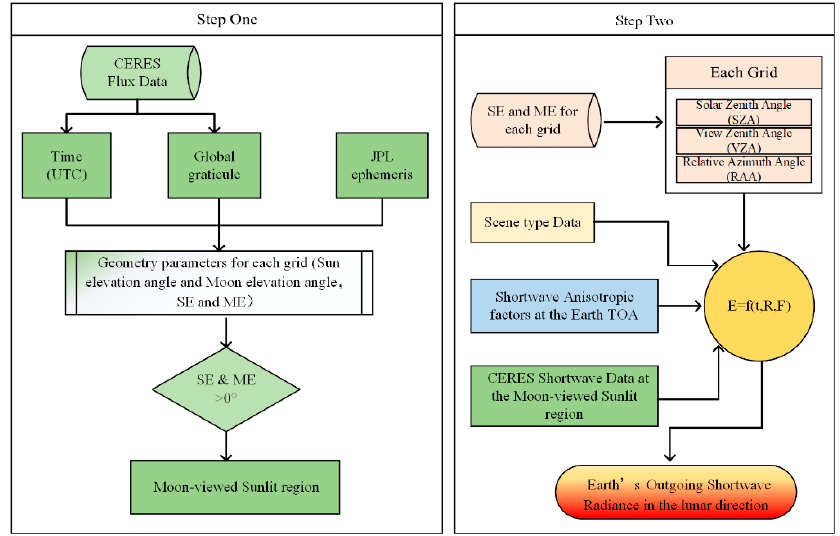
Figure 1. Flowchart of the model established for deriving Earth’s outgoing shortwave radiance in the lunar